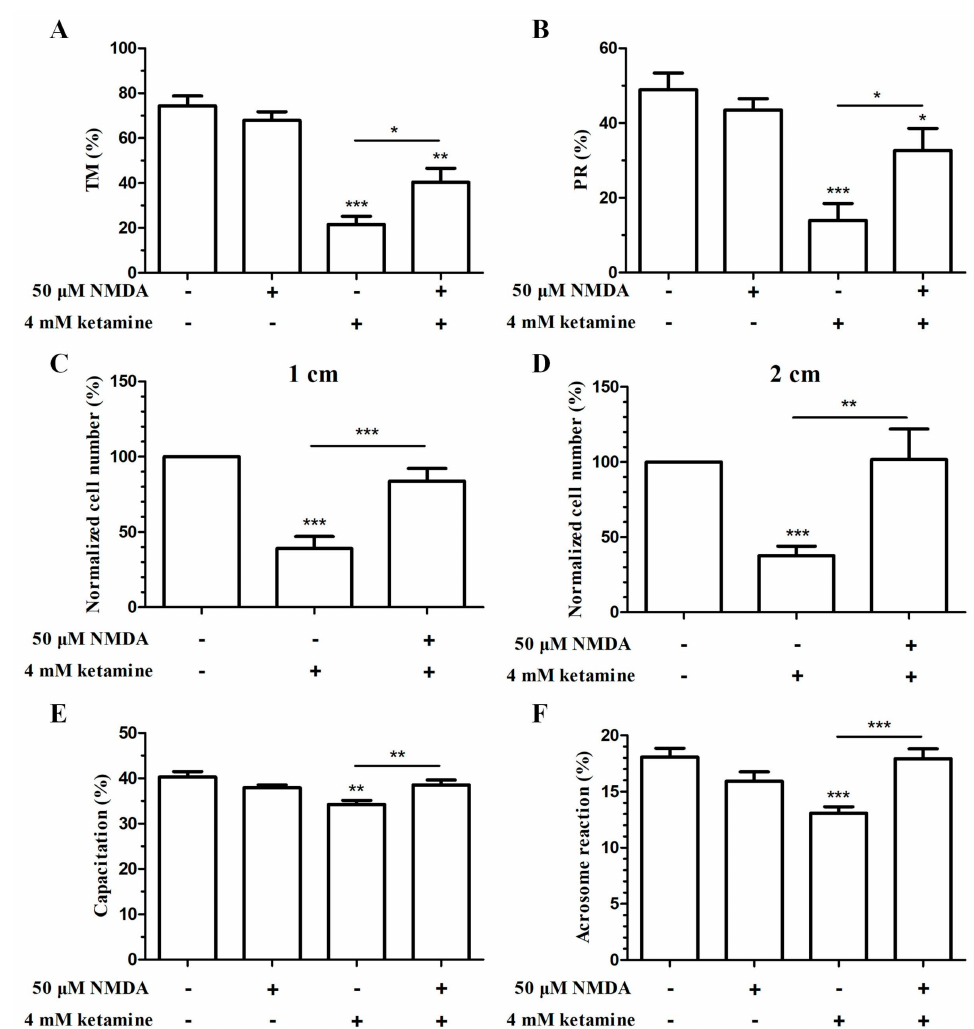
Figure 3. The NMDA receptor participated in ketamine inhibitory effects on human sperm functions, including motility, penetration ability, capacitation, and acrosome reaction. Effects of 4 mM ketamine and 4 mM ketamine plus 50 µ M NMDA on human sperm total motility ( A ) and progressive motility ( B ) ( n = 7). ( C , D ) Effects of 4 mM ketamine and 4 mM ketamine plus 50 µ M NMDA on human sperm penetration ability ( n = 15). Human sperm was incubated with 4 mM ketamine and 4 mM ketamine plus 50 µ M NMDA in HTF++ at 37 ◦ C in an incubator with 5% CO 2 for 4 h. The capacitation ( E ) and acrosome reaction ( F ) of human spermatozoa were examined by CTC staining. Two hundred sperms were counted in each assay to evaluate the different CTC staining patterns. Bar: mean ± SEM, n = 7, one-way ANOVA; * p < 0.05, ** p < 0.01, *** p <